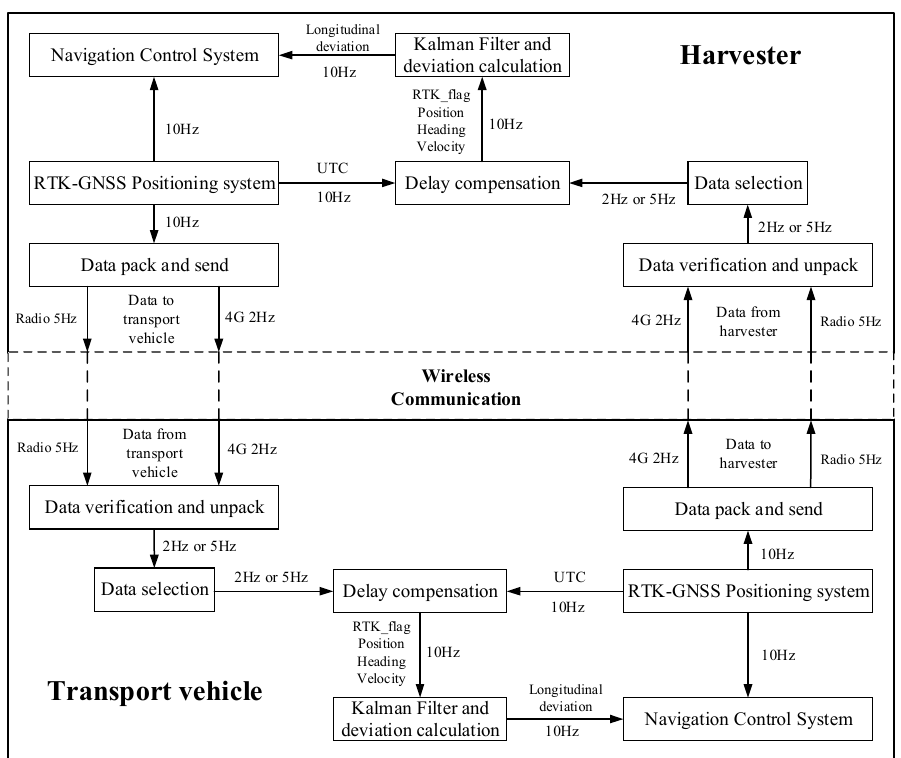
Figure 4. Schematic diagram of the overall structure of information